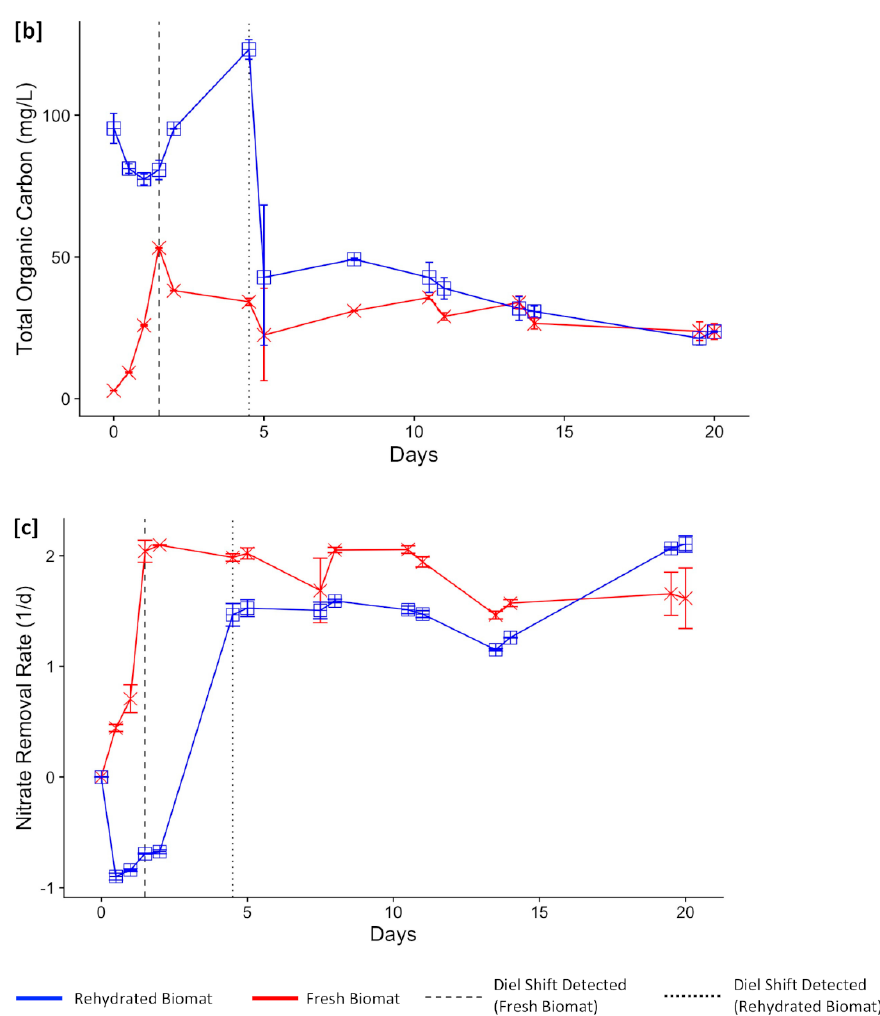
Figure 4. Comparison of rehydrated to fresh biomat for ( a ) nitrogen species, ( b ) total organic carbon, and ( c ) first order removal rate of nitrate at each sampling point. During the startup phase of rehydration, an initial pulse of nitrogen ( a ) made up mostly by nitrate was seen within the rehydrated biomat microcosms. The total organic carbon (TOC) pulse did not peak until biomat activity was measurable in either biomat types ( b ), demonstrating a need for additional research to determine the scale of an organic carbon plume that may be released upon rehydration. First order nitrate removal rates ( c ) did not stabilize in either biomat type until measurable biomat activity occurred (~1.5 days in fresh and 4.5 days in rehydrated). At that point, the removal rates of both types of biomat were not significantly different. Points represent the average of biological duplicates with error bars